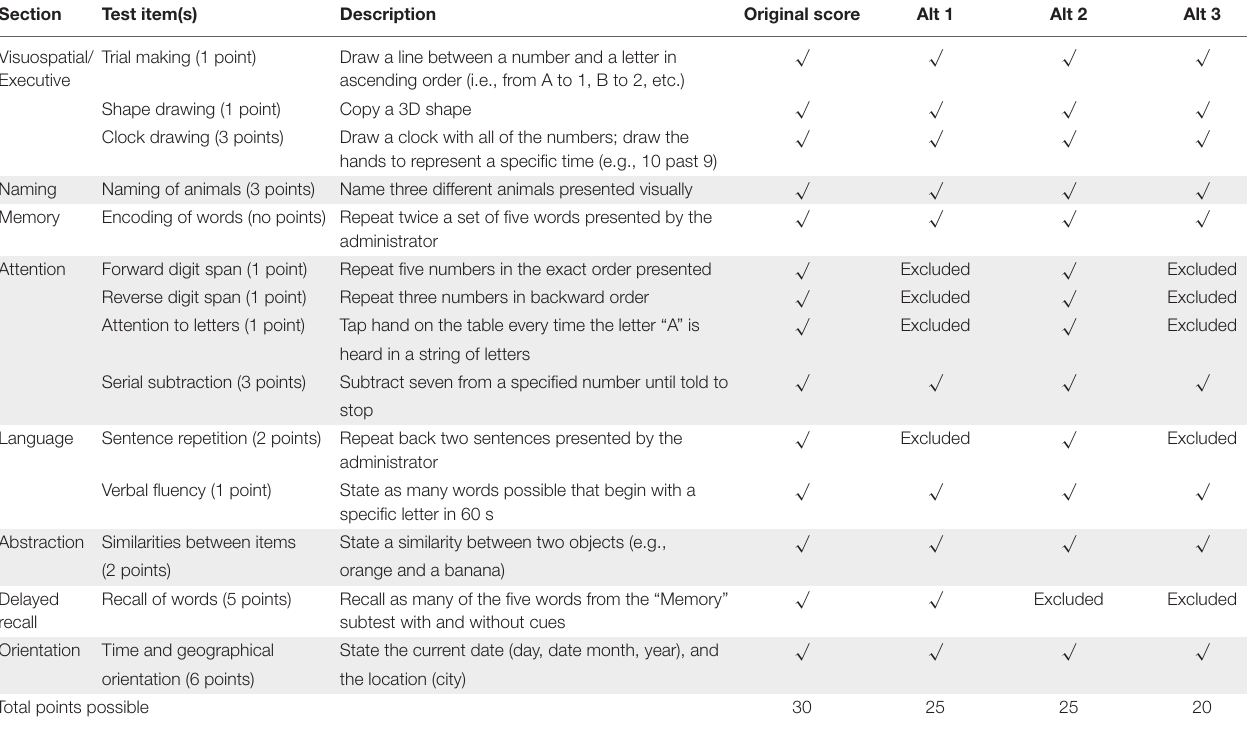
TABLE 2 | Description of the standard MoCA and point allotment for original and alternate scoring methods. Section